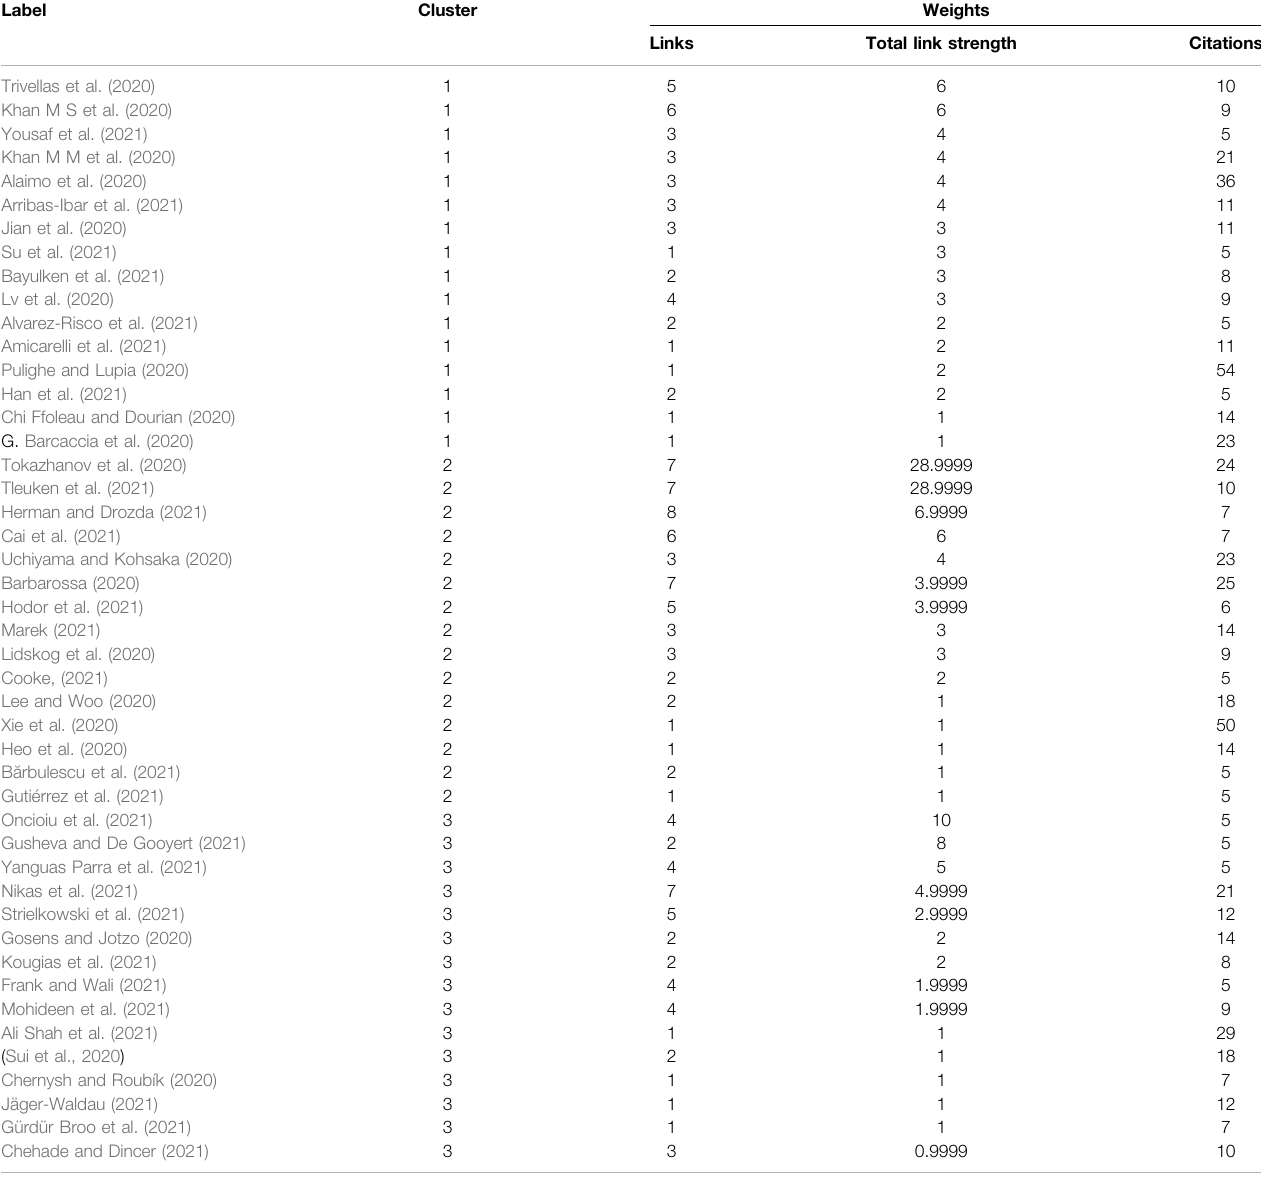
TABLE 12 | Bibliometric coupling.